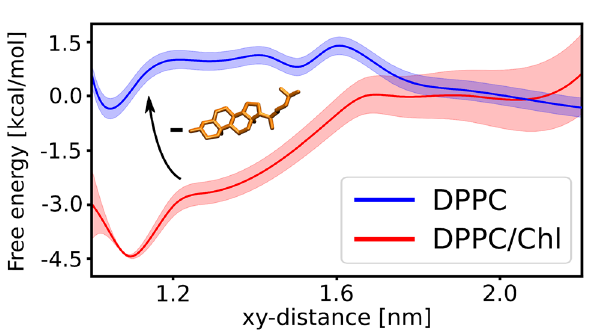
Figure 4. The free energy profile for the substrate binding by γ -secretase in the presence (red) or absence (blue) of cholesterol in DPPC